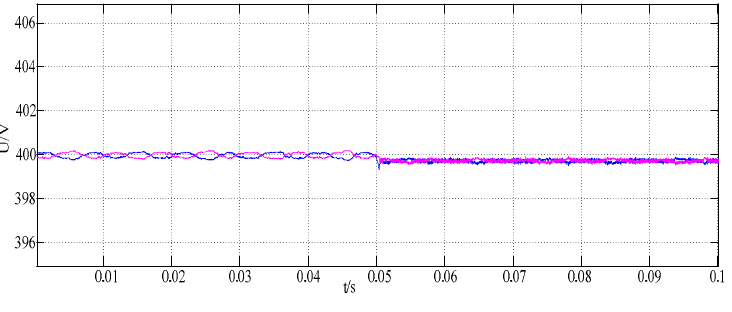
Figure 14. Capacitor voltage of C1 and C2 .